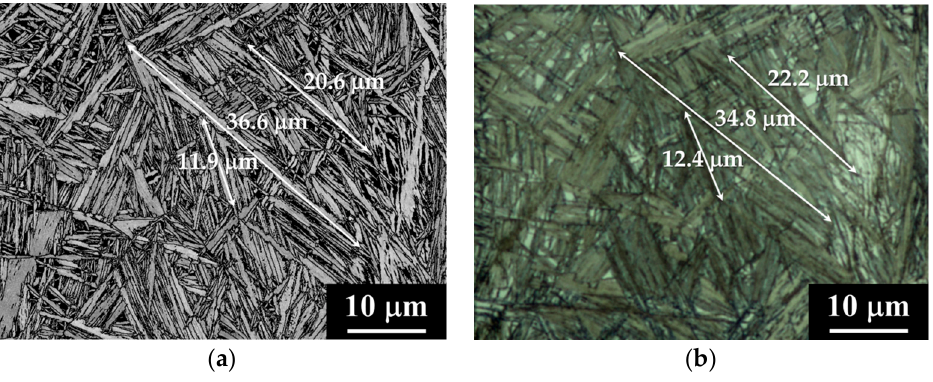
Figure 6. EBSD-LOM correspondence for the 1C-2.5Si-950-250-16 specimen ( a ) EBSD Band Contrast map for the ferrite phase where black lines represent the crystallographic block boundaries; and ( b ) corresponding light optical micrograph. The white arrows indicate the length of the crystallographic blocks as measured with both techniques.